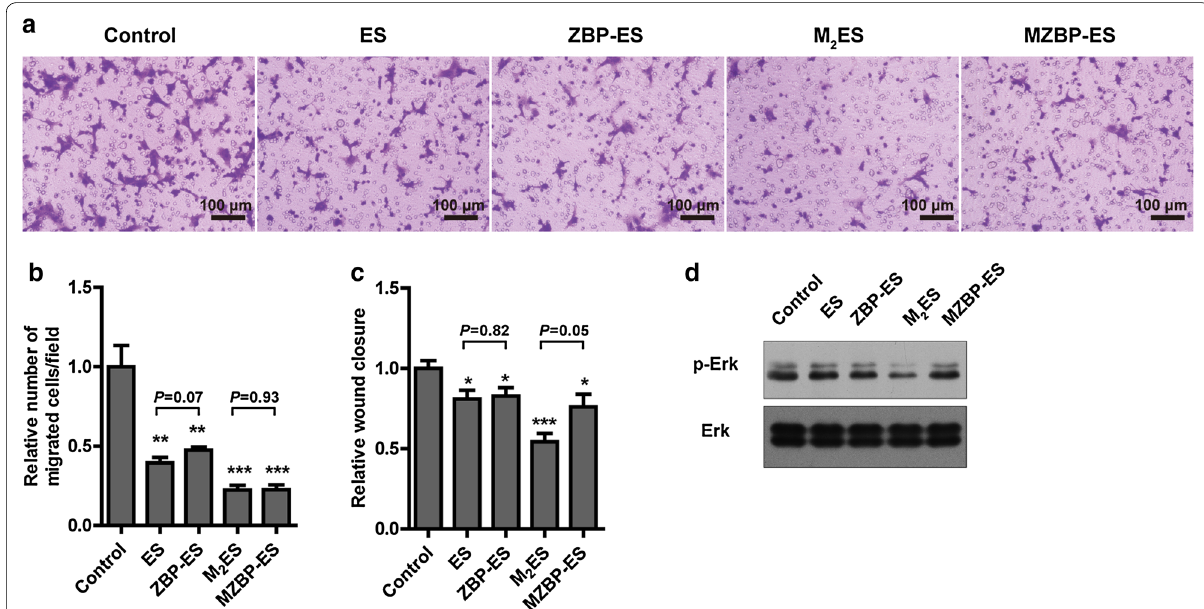
Fig. 3 Biological activities of ES variants. a and b Representative images and quantified results of the Tranwell migration assay for endothelial cells. Human microvascular endothelial cells ( HMECs ) were seeded into the upper well of the Boyden chamber and treated with the indicated proteins for 6 h. Cells were stained with crystal violet, photographed, and counted. c In the wound healing assay, the HMEC monolayer was scratched and cultured in serum-free media in the absence or presence of the indicated proteins for 48 h. Cells were photographed at 0 and 48 h, respectively, and the relative wound closure was quantified. d Erk phosphorylation of ES variant treatments examined by Western blotting. Error bars indicate standard deviations (SDs). * P < 0.05, ** P < 0.01, *** P < 0.001, vs.